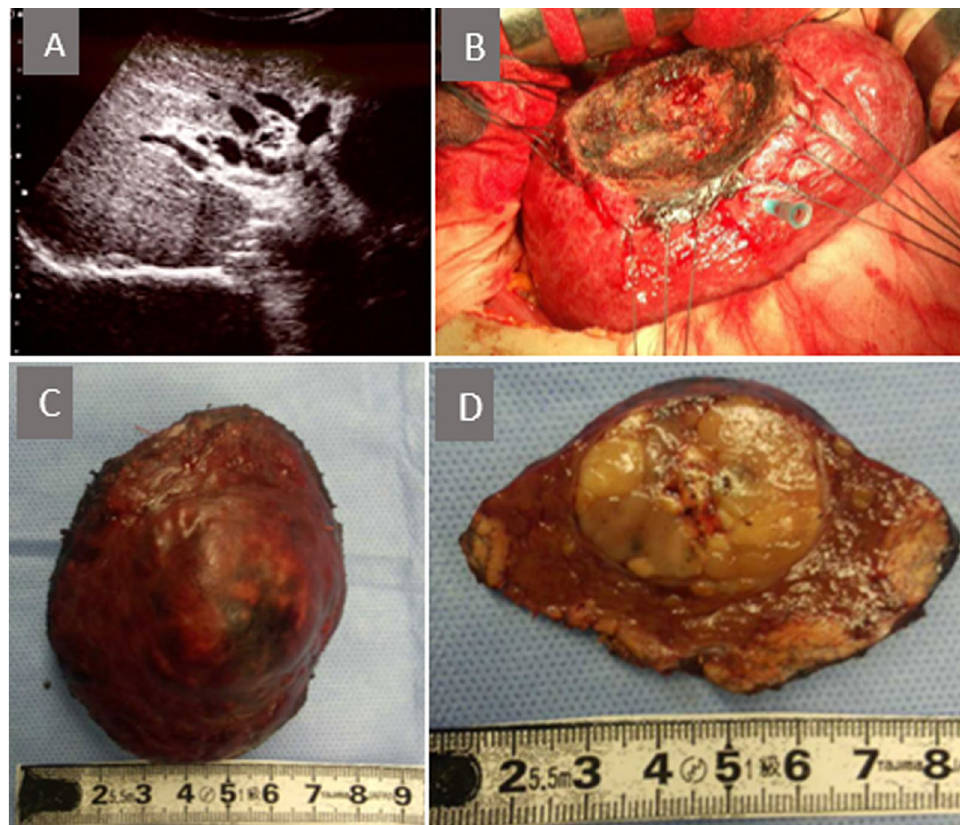
Fig. 5 A Intraoperative ultrasonography showed the complex branching of the portal vein in hilus of the liver. B Liver partial resection was performed. C , D Resected